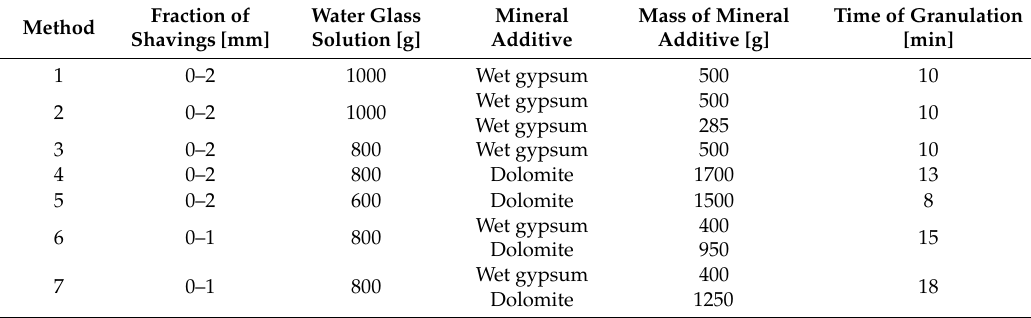
Table 5. Process parameters of